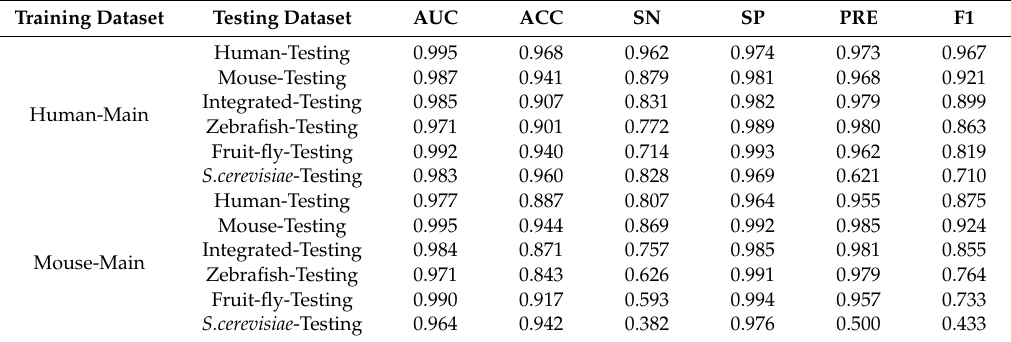
Table 5. The performances of PredLnc-GFStack models on multi-species testing datasets.